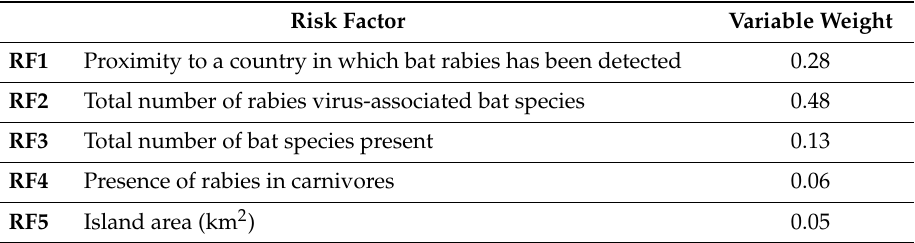
Table 2. Risk factors for bat rabies presence in the Caribbean islands, and variable